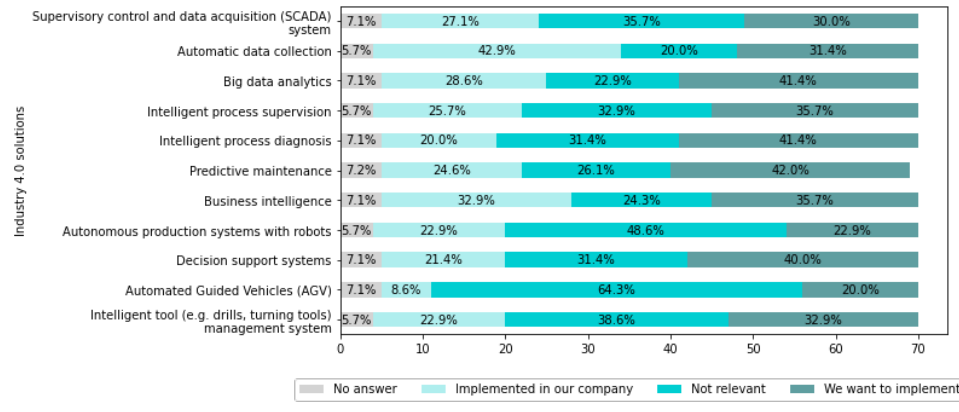
Figure 20. Important Industry 4.0 solutions for the companies — number of questionnaires in a total number of 70 questionnaires.